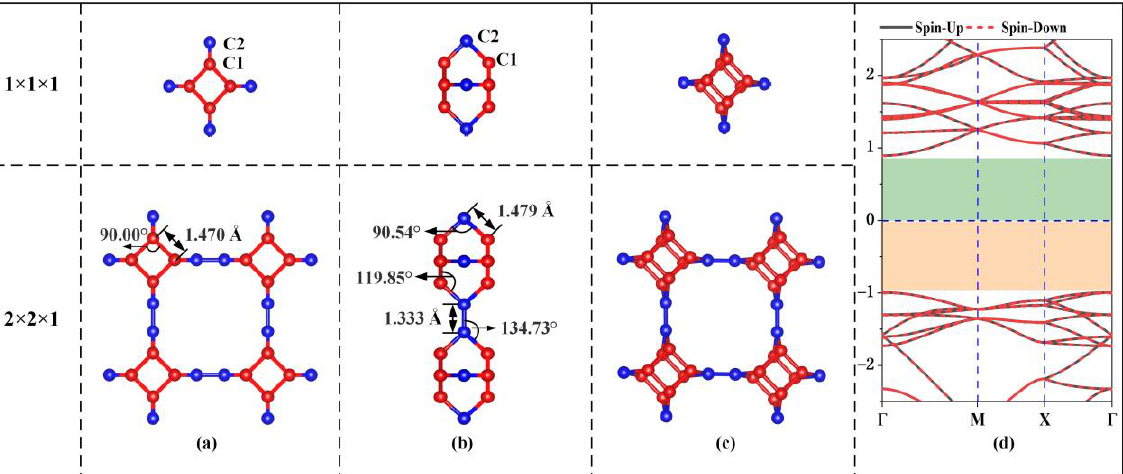
Figure 1. Geometrical structure ( a ) Top view; ( b ) Side view; ( c ) Bird’s-eye view, and electronic band structure ( d ) of TTG.